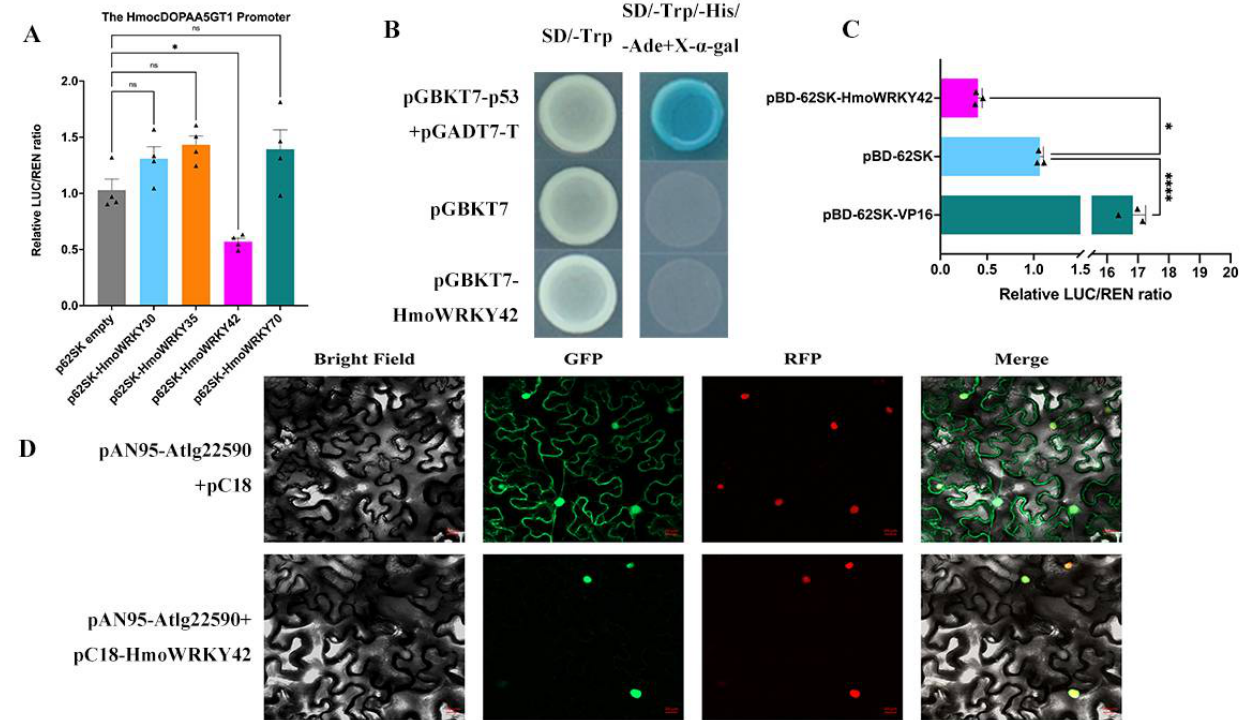
Figure 6. HmoWRKY42 is a nucleus-localized transcription repressor. ( A ) HmoWRKY42 inhibited the transcription of HmoCDOPA5GT1 by dual-luciferase transient expression assay in Nicotiana benthamiana leaves. ( B ) Analysis of the transcriptional activity of HmoWRKY42 in yeast cells. ( C ) Transcriptional activation of HmoWRKY42 in N. benthamiana leaves. The LUC/REN ratio of the empty BD-62SK vector was used as a calibrator (set as 1). BD-62SK-VP16 was used as a positive control. ( D ) Subcellular localization of HmoWRKY42 in the leaves of N. benthamiana . Bars = 20 µ m. Small triangles represent the distribution of data for each biological replicate. Data represent mean val- ues from three biological replicates ( ± S.D.). Non- significant (ns), *, and **** indicates significant differences at p -value > 0.05, <0.05, and 0.0001 using two-tailed t -test,